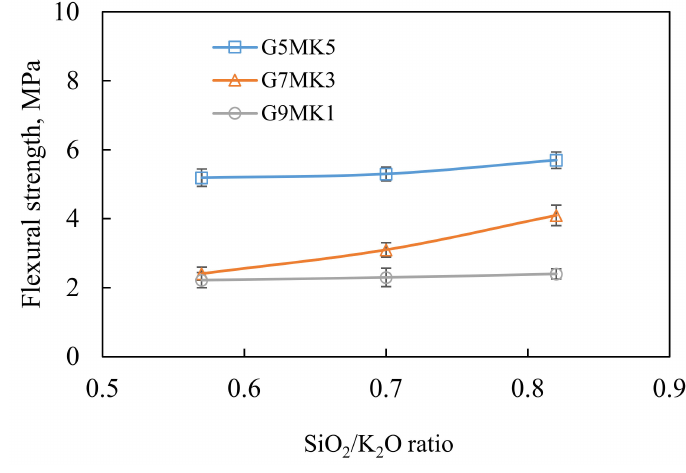
Figure 5. Green flexural strength of geopolymer slurry.